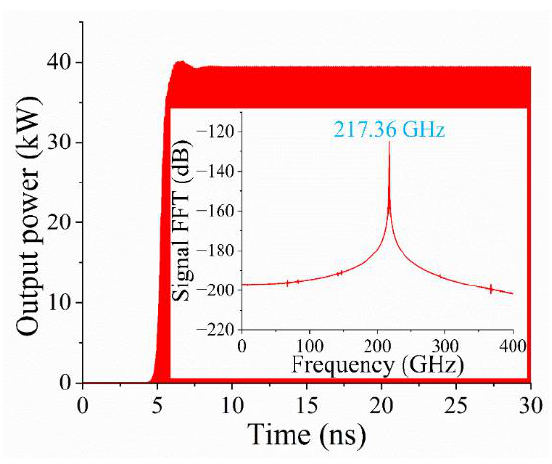
Figure 5. Time-dependent output power and frequency spectrum of CST Particle Studio simulation results.